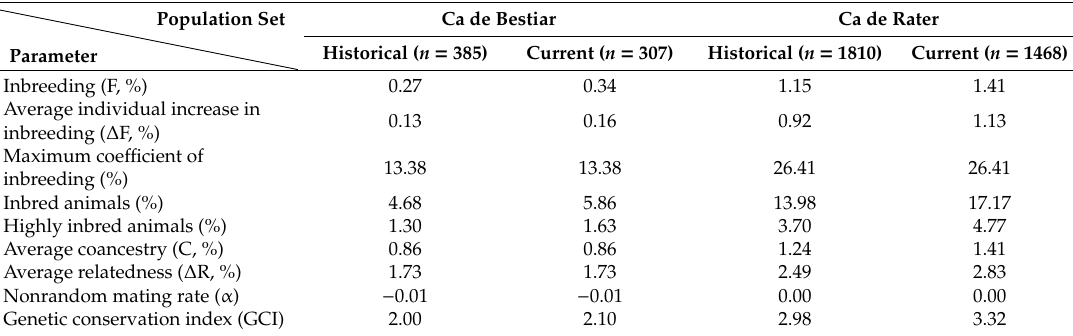
Table 2. Summary of identity-by-descent estimators, nonrandom mating rate ( α ), and genetic conservation index (GCI).